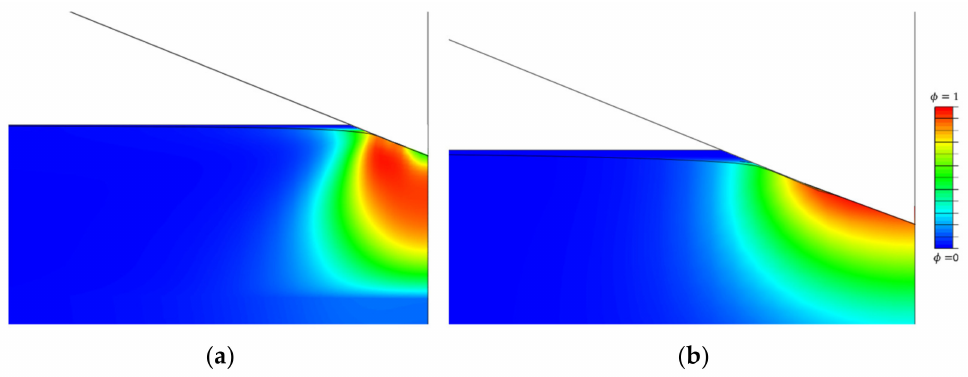
Figure 3. Comparison of ( a ) Miehe and ( b ) Amor energy decomposition.